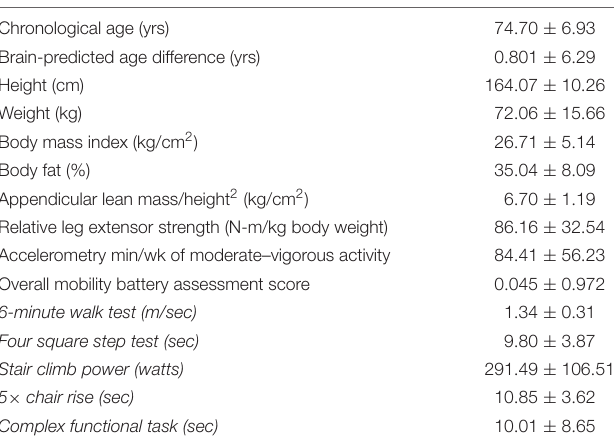
TABLE 2 | Participant demographics and functional